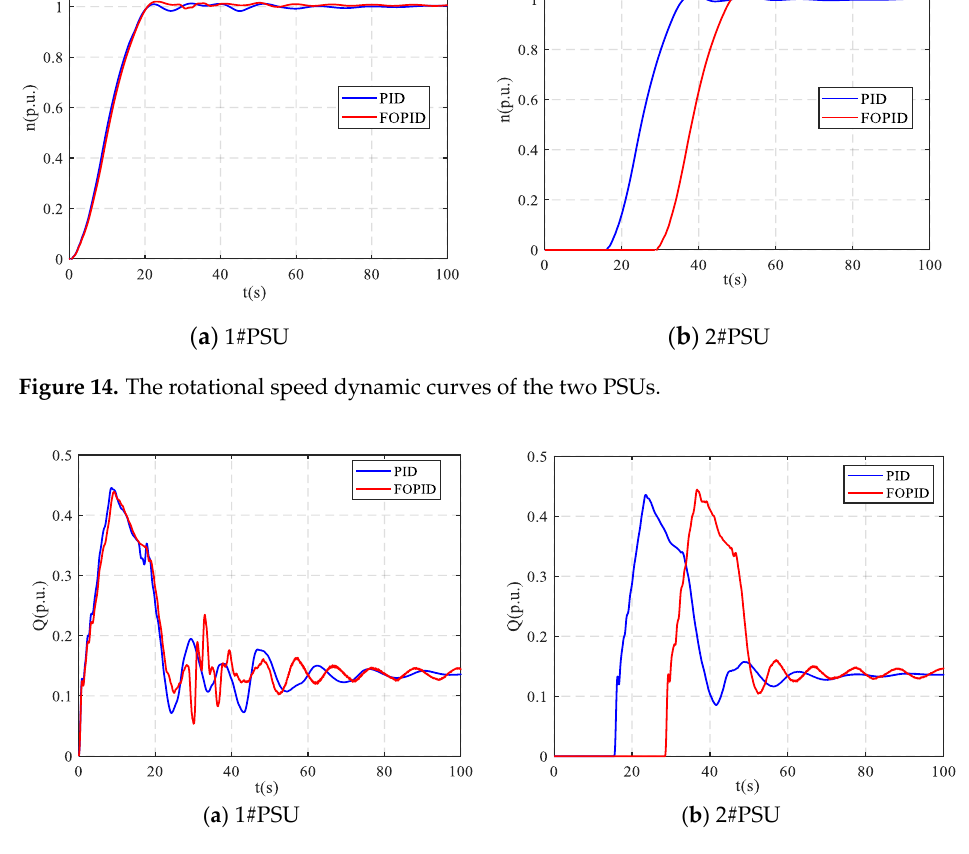
Figure 15. The flow dynamic curves of the two PSUs.